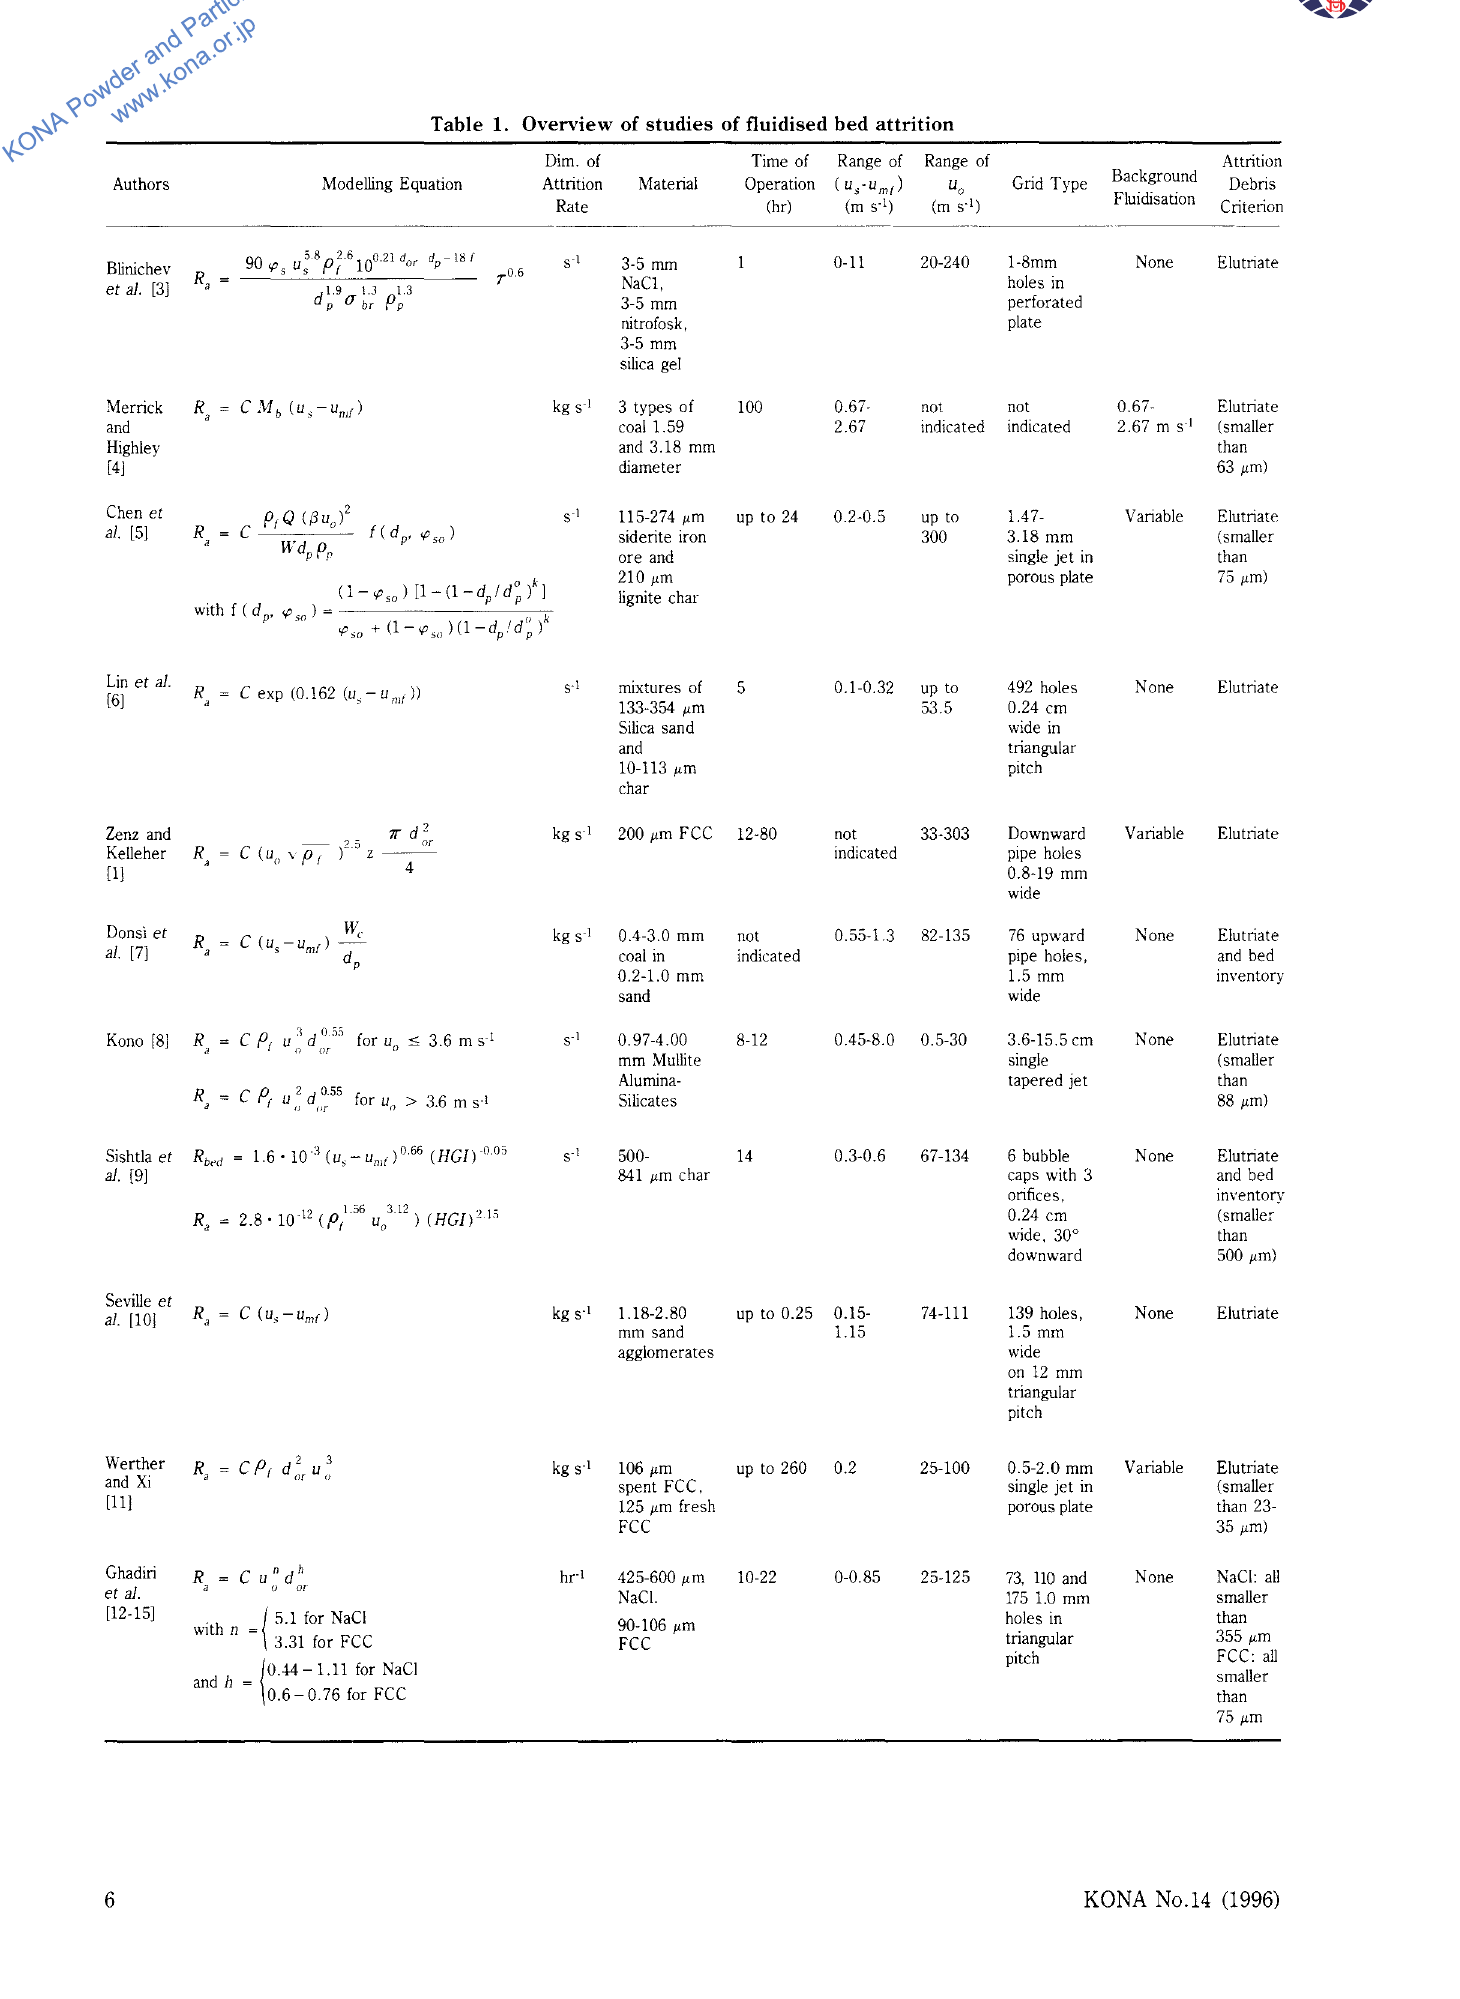
Table 1. Overview of studies of fluidised bed attrition Dim.